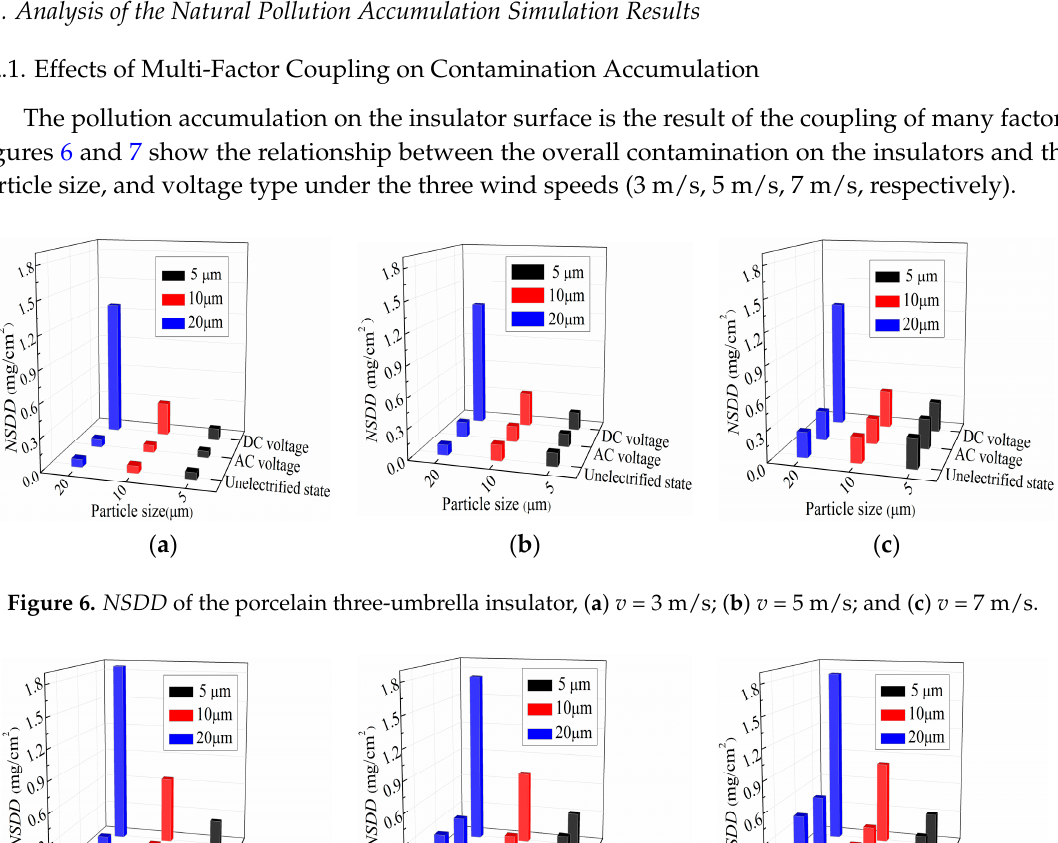
Figure 5. Insulator skirt number.